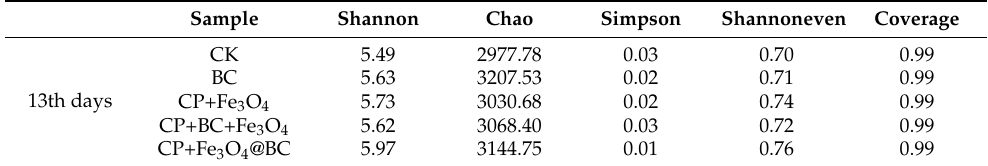
Table 2. Diversity Index Statistics in